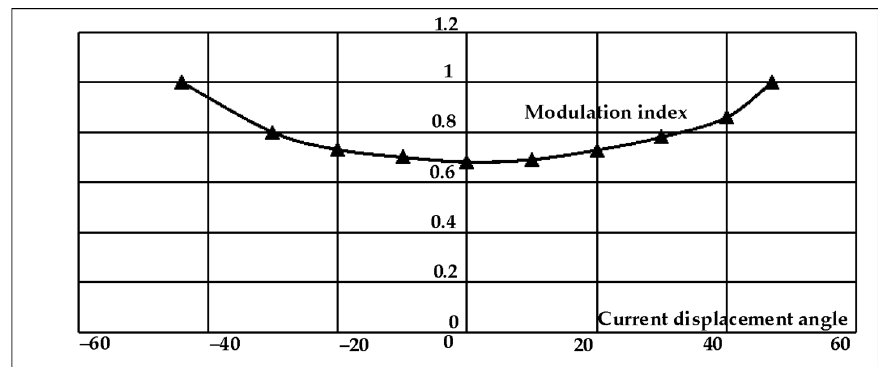
Figure 14. ISVM modulation index for the voltage drop recovering as a function of the current displacement angle.